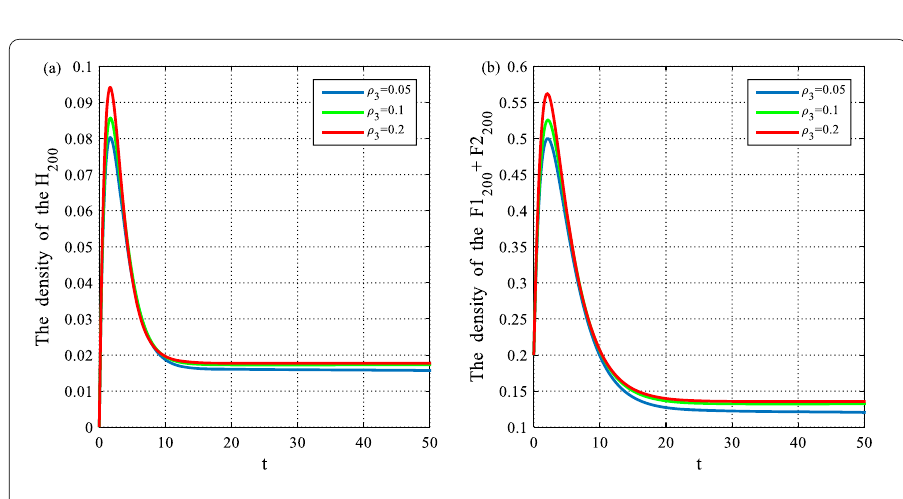
Figure 12 The density of H 200 and F 1 200 + F 2 200 under different ρ